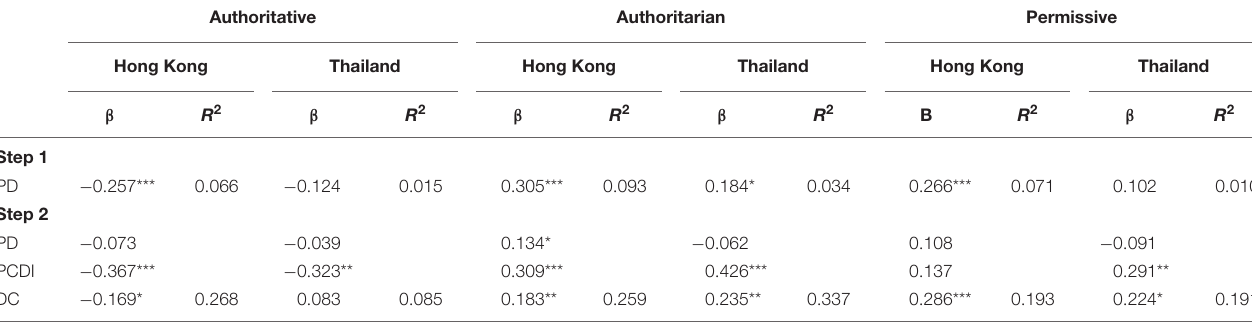
TABLE 6 | Hierarchical regressions: parenting stress subscales predicting parenting